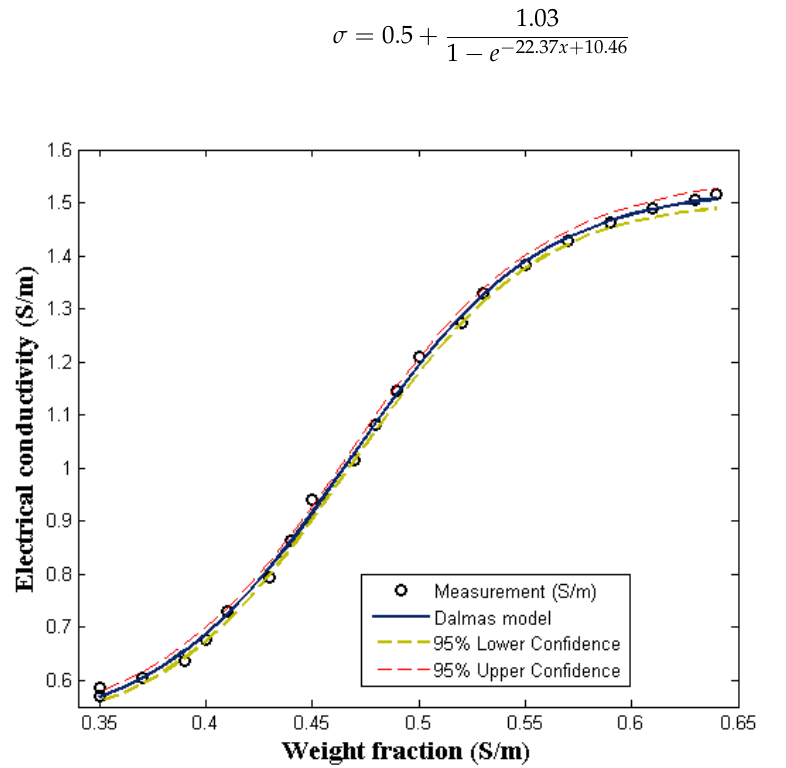
Figure 3. Comparing the linearized Ondracek model (LOM) with experimental measurement.